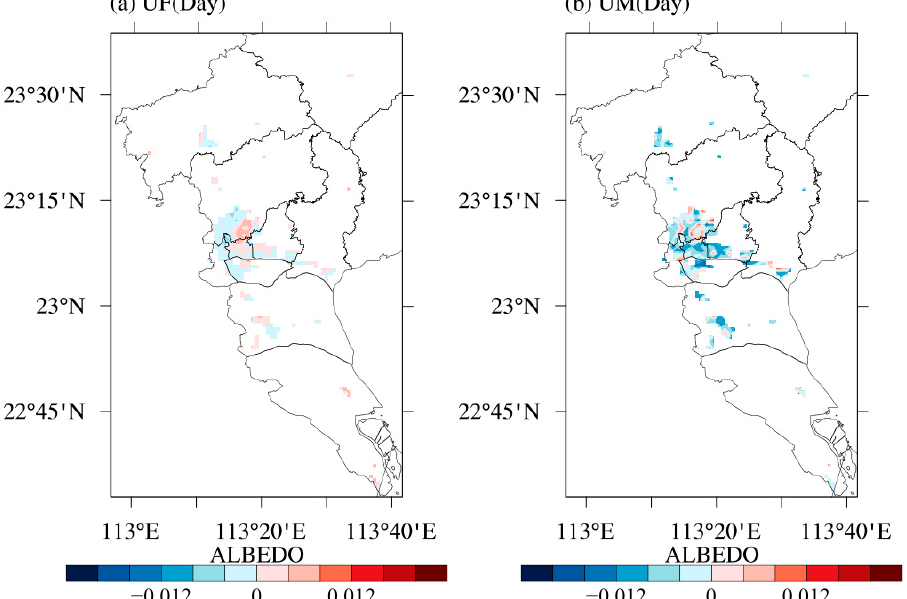
Figure 5. Impacts of the high-resolution UF and UM on the average albedo during the daytime in the urban underlying surface of Guangzhou. Here, the impacts of UF/UM during daytime were calculated by comparing the simulated hourly albedo values from 08:00 LST to 16:00 LST for 10 days (from 1 to 10 November) in two experiments and then averaging the result. ( a ) Effect of UF (Case 1–Base); ( b ) Effect of UF (Case 1–Base). GRD is generally negative during the daytime and positive at night. During the daytime, heat is transferred from the surface to the ground, and at night, heat is conducted from the ground toward the surface. Figure 6 shows the effect of high-resolution UF and UM parameters on the mean GRD for the daytime (08:00–16:00 LST) and night-time (17:00–07:00 LST) in the underlying urban surface of Guangzhou. During the daytime (Figure 6a,b), negative values (blue shading) indicated increased GRD and positive values (red shading) indicated decreased GRD. It is evident from Figure 6a that, during the day- time, the increased UF value (0.53) in the urban-centre districts increased the heat transfer from the surface into the ground by 2.690 W/m 2 , whereas in the suburban districts, the re- duced UF (0.36) decreased the heat transfer from the surface to the ground by 14.244 W/m 2 . Similarly, the high-spatial-resolution UM parameters also notably increased the GRD in the districts (Figure 6b) with narrowed street canyons (Figure 3d). This phenomenon was related to the TSK in those districts: as the UF increased and street widths decreased, the TSK increased, ultimately resulting in higher heat transfer from the surface to the ground. During the night-time (Figure 6c,d), positive values (red shading) indicated increased GRD, and negative values (blue shading) indicated decreased GRD. As the soil heat stor- age increased during the daytime, in the districts with greater UF values, the amount of heat transferred from the ground to the surface at night also increased (central districts: 1.076 W/m 2 ). With the high-resolution UM parameters, the street canyon widths in some areas of the YX, HZ, TH, and BY districts were decreased, so the heat storage of soil during the daytime and the amount of heat released at night increased in those districts. In contrast, in the districts in which the street canyon widths increased, the heat storage of soil during the daytime was reduced (Figure 6d). Therefore, in the districts where the street canyon widths decreased, the heat flux from the ground to the surface increased, resulting in an increase in the night-time TSK in the corresponding districts; in the districts where the street canyon widths increased, the heat flux from the ground to the surface decreases, resulting in decreased night-time TSK in those